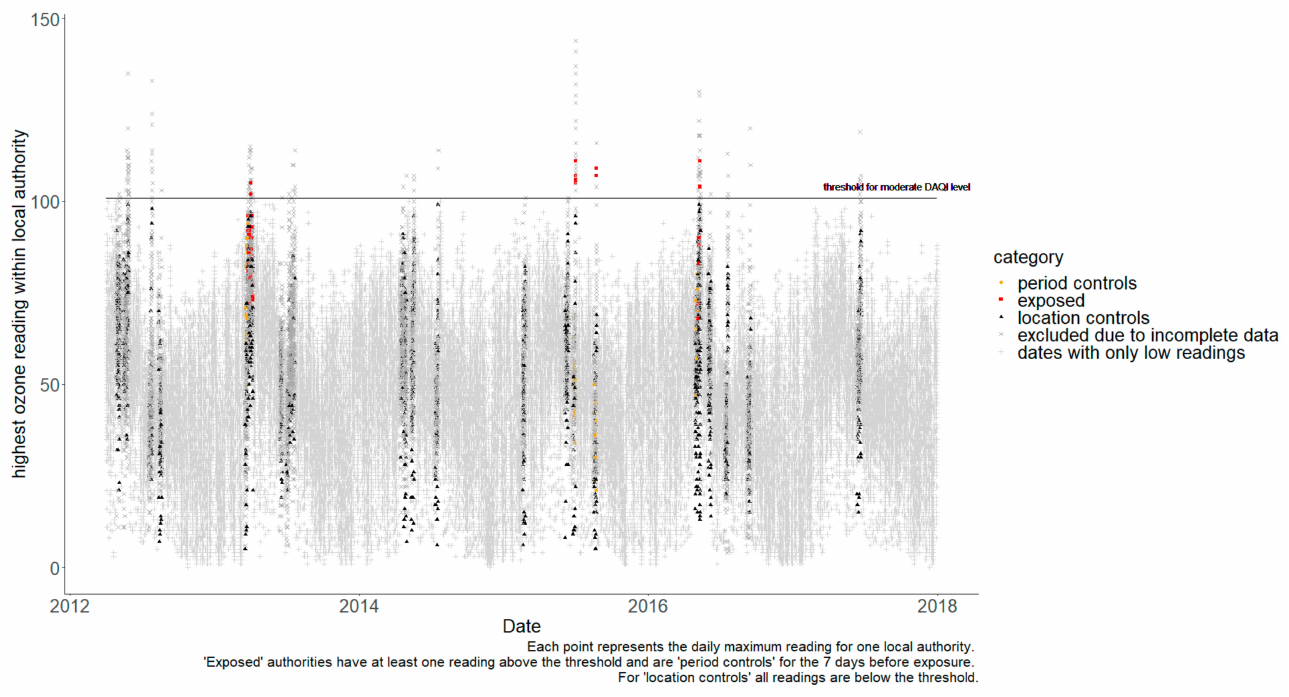
Figure 2. Daily maximum readings for O 3 by local